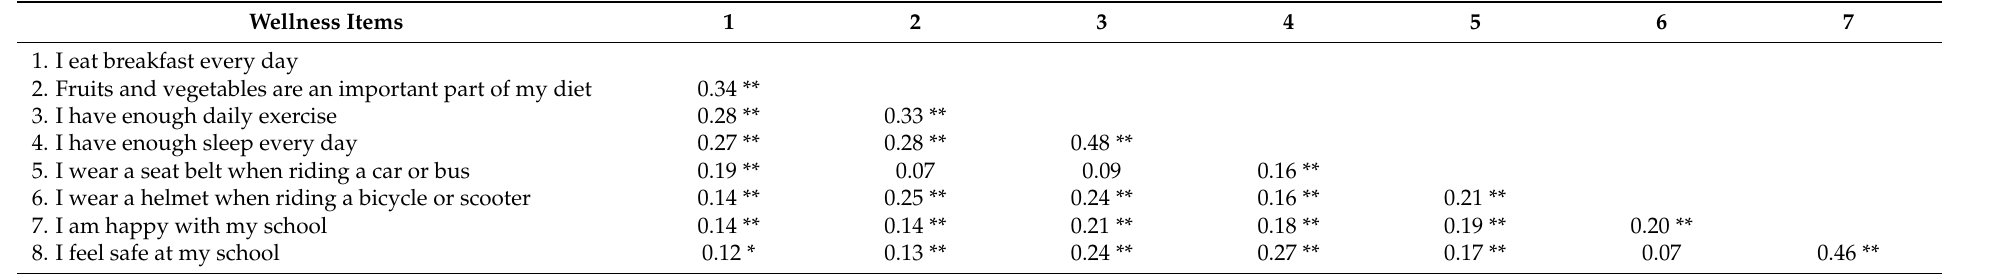
Table 8. Correlation matrix of the SWS items.